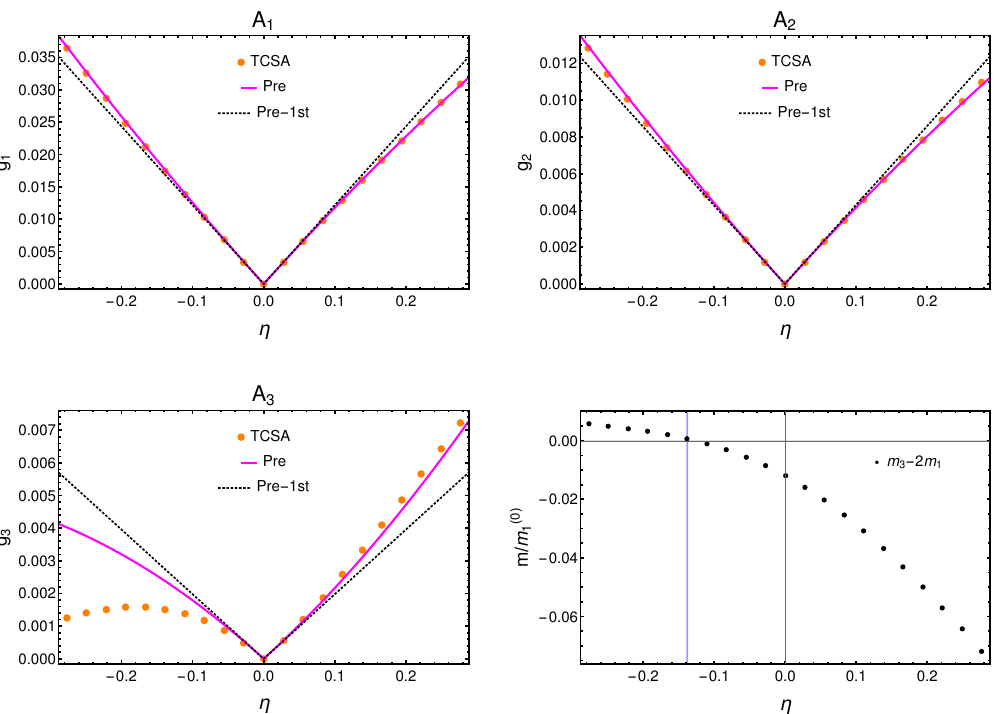
Figure 7 . The overlaps of the three lowest-lying one-particle states for non-integrable quenches as functions of η (5.15) compared with TCSA data for m pre R = 40. Adding the second order yields 1 better agreement in all cases. We observe sizeable deviation only in the case of the third particle in the paramagnetic direction due to the state becoming unstable, i.e. m 3 > 2 m 1 , as it is shown in 0 . 138 is indicated by a blue grid the bottom right panel. The stability threshold η 3 = −